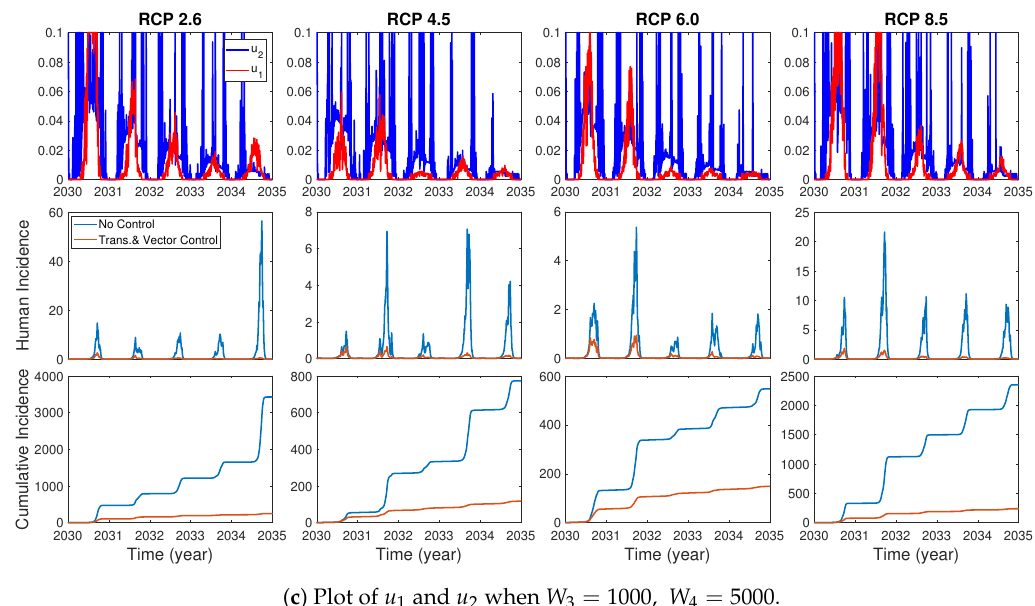
( c ) Plot of u 1 and u 2 when W 3 = 1000, W 4 = 5000. Figure A2. The effect of different weight constant values on the optimal control